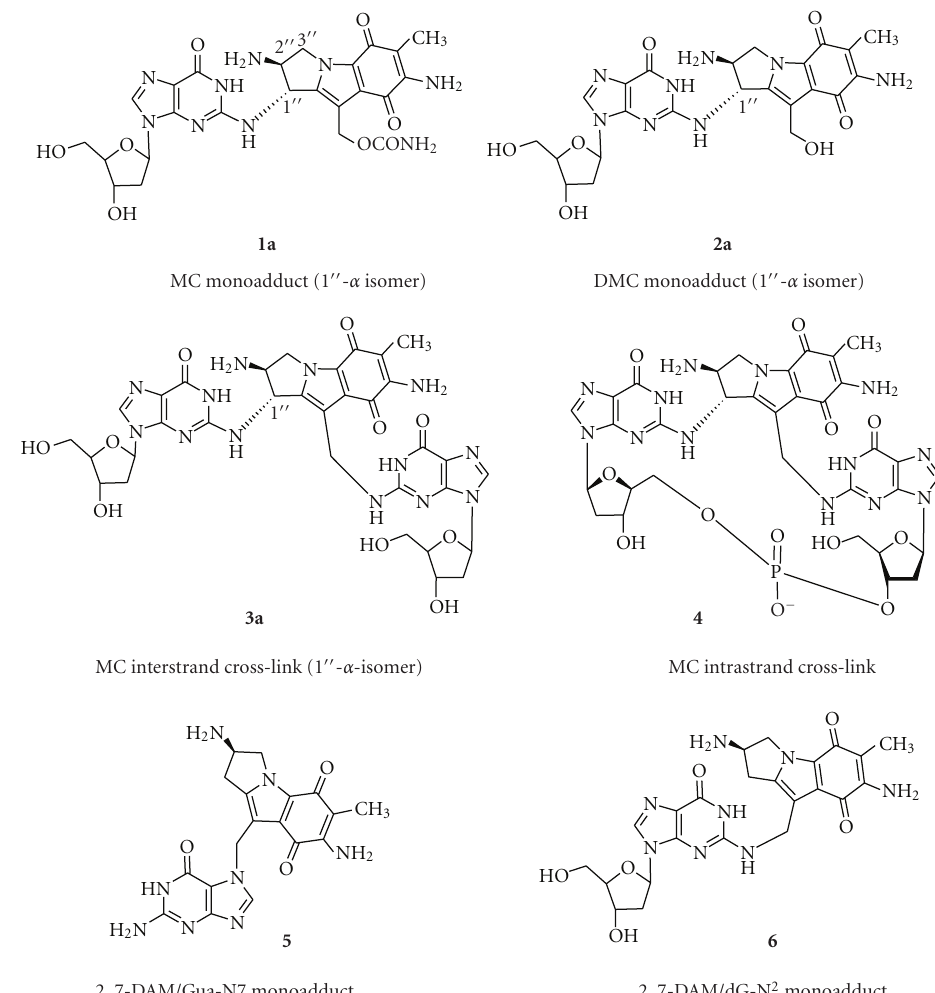
Figure 2: Chemical structure of six major adducts of reductively activated MC. (Reproduced with permission from the reference in Figure 1.